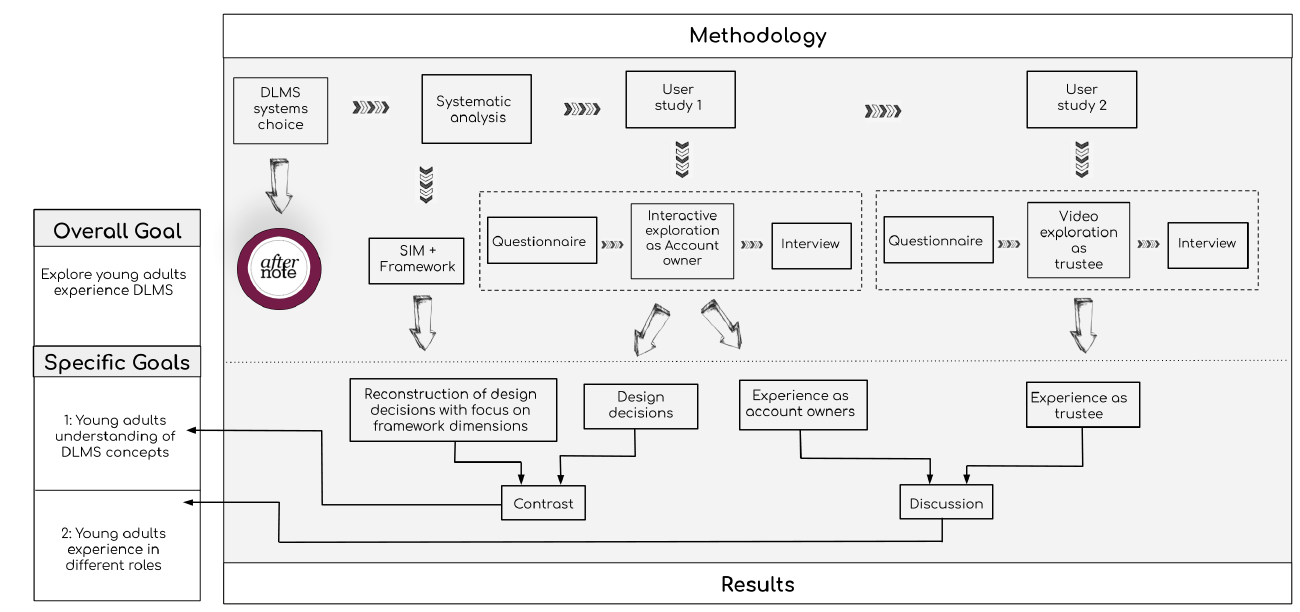
Fig. 10. Overview of the methodology